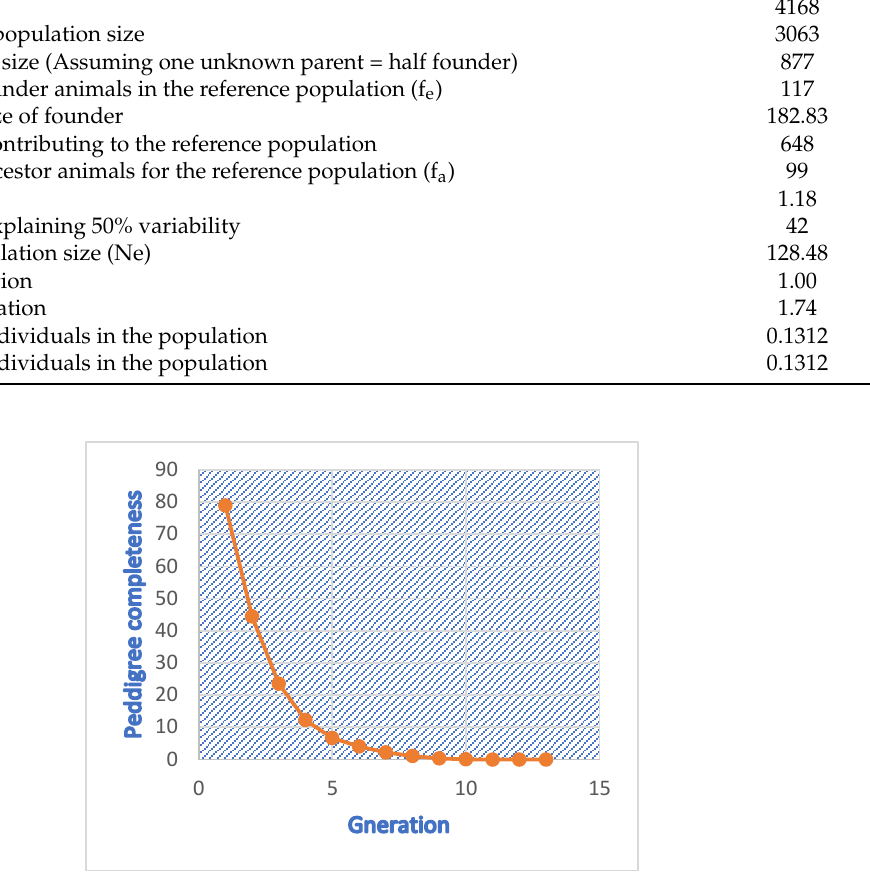
Figure 2. Per cent pedigree completeness in Mecheri Sheep. The average relatedness and inbreeding coefficient were determined for each individ- ual; their mean values for each generation are shown in Table 6. The average percentages of inbreeding for the whole population, pedigreed population, and inbred animals were 0.45, 0.61, and 3.41 per cent, respectively. In the whole population, only 1.65 per cent of the animals had more than 10 per cent inbreeding. The mean inbreeding values in the population ranged from 0.005 to 0.010 over generations. The generation-wise inbreeding increased from the second generation (0.5%) to subsequent generations and reached its maximum in the fifth generation (1.00%). Thereafter, it decreased and fluctuated between 0.86 per cent and 0.44 per cent across the sixth to twelfth generations (Figure 3). A total